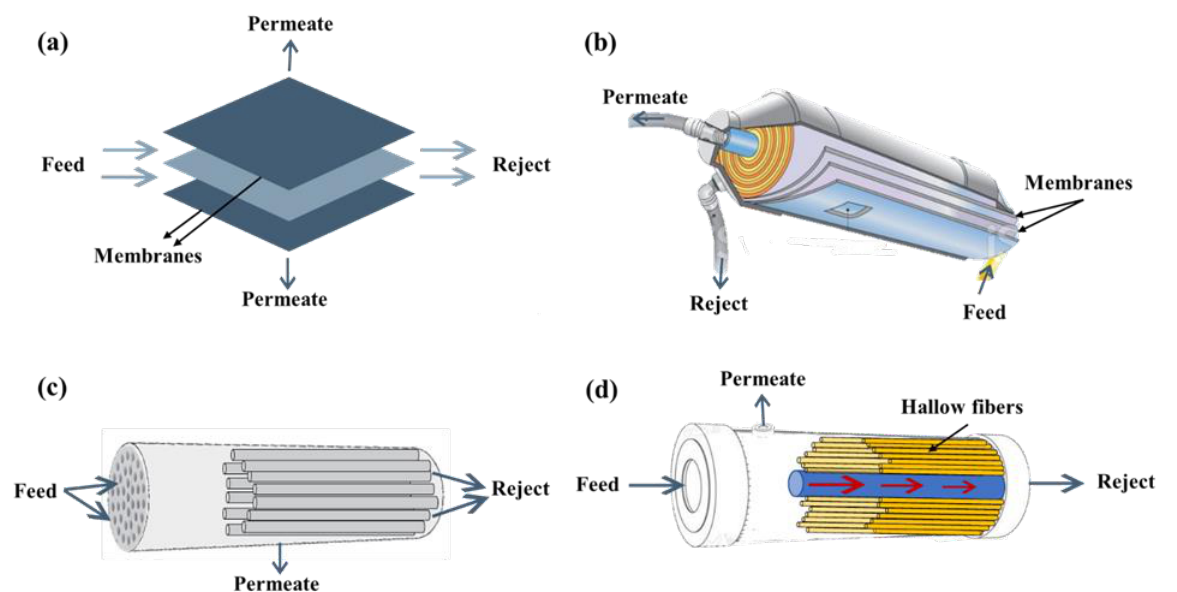
Figure 5. Membrane configurations: ( a ) plate and frame, ( b ) spiral wound, ( c ) tabular, and ( d ) capillary fiber.